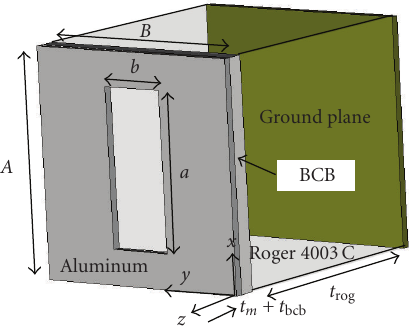
Figure 1: Unit cell of rectangular slot grounded